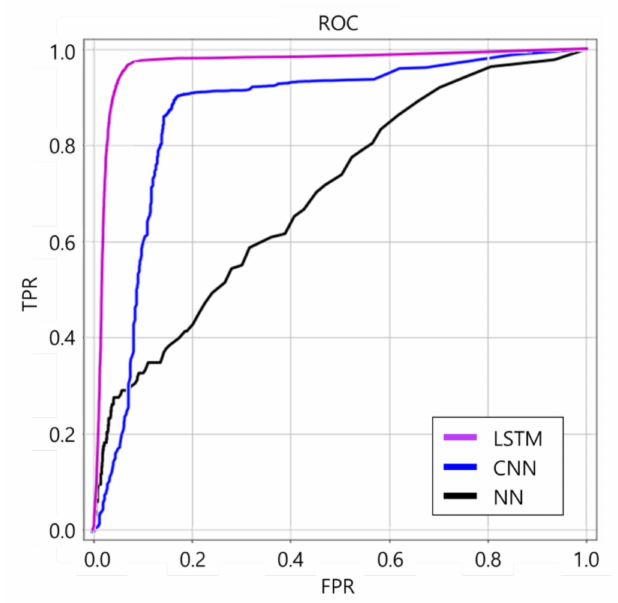
Figure 12. ROC curves of LSTM, CNN, and NN.